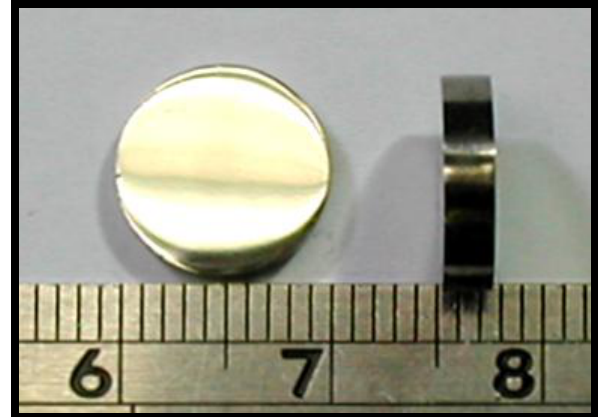
Figure 4. Outer morphology of Ti 50 Cu 28 Ni 15 Sn 7 with 4% vol. CNT particles after vacuum hot pressing at 723 K under a pressure of 1.2 GPa.